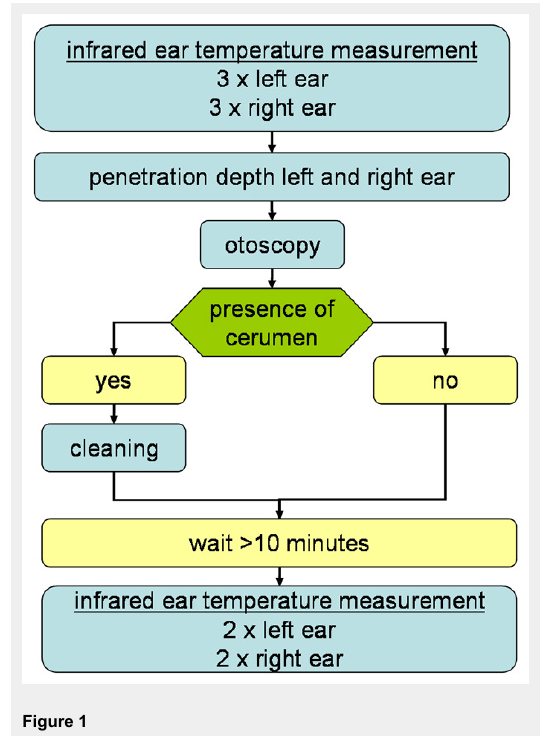
Flow chart of the standard